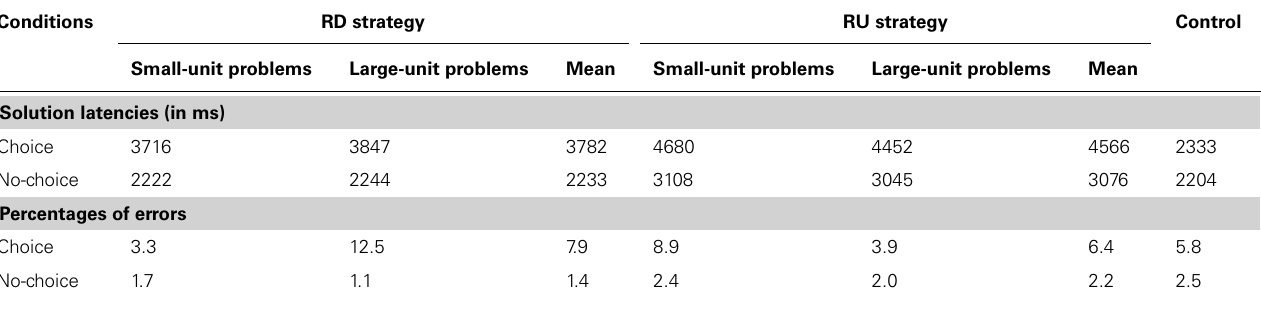
Table 2 | Mean solution latencies (in ms) and mean percentages of errors as a function of strategies and problems in each condition.